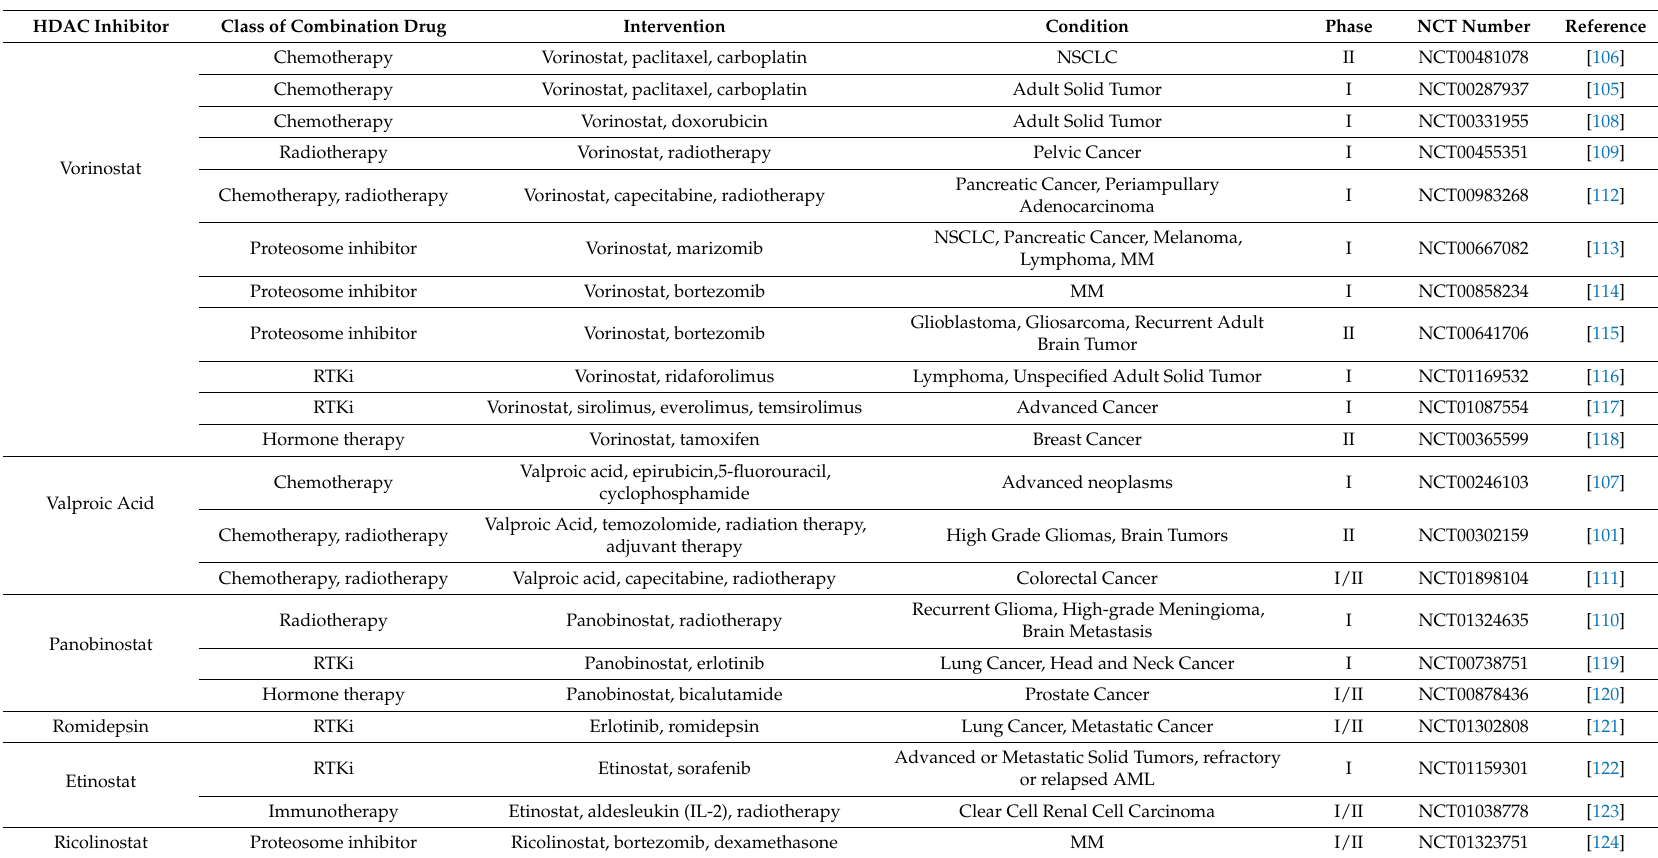
Table 1. Summary of published clinical trials evaluating HDAC inhibitors (HDACi) in combination with other anti-cancer compounds. HDAC